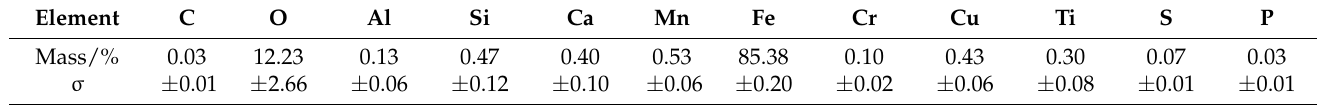
Figure 3. Result of measurement on a scanning microscope Hitachi S-3400N (HITACHI, Tokyo, Japan) equipped with an EDS and WDS detector. On the left, an image of mill scale, on the right, the spectrum of the chemical composition obtained after analysis of the entire area. Table 1. Average chemical composition of tested mill scale.